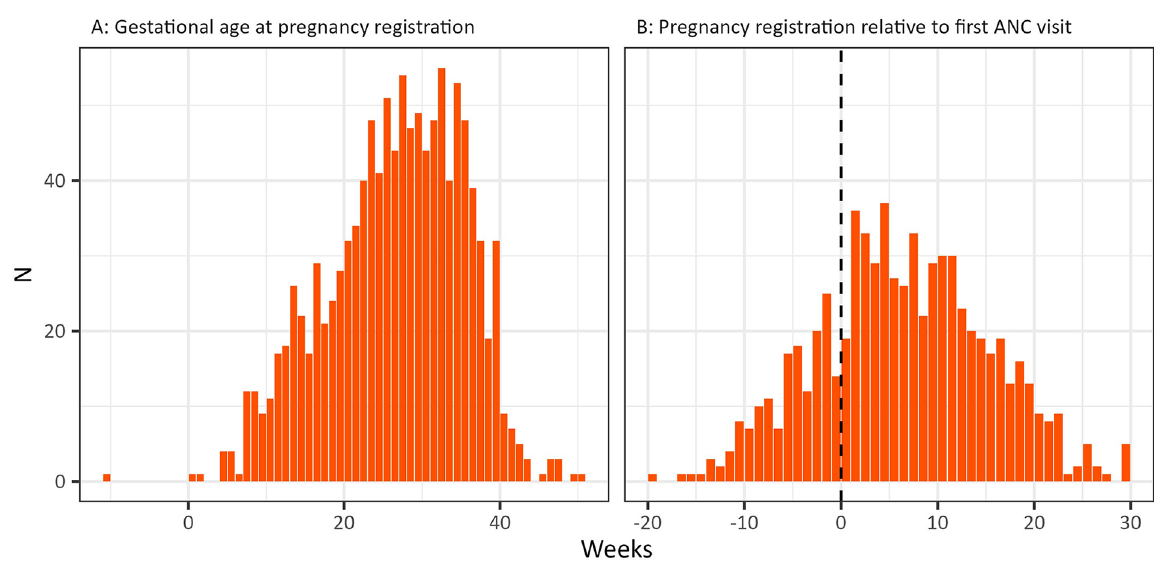
(A) Histogram of gestational age at the time of HDSS pregnancy registration (n = 1,141). Gestational age was calculated from